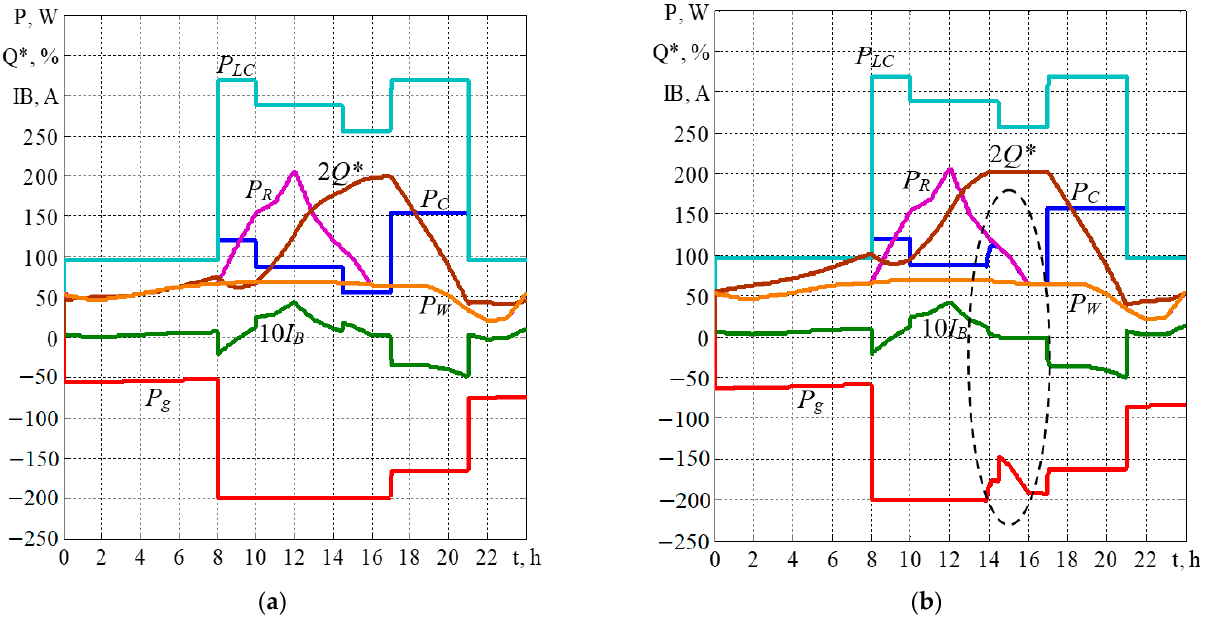
Figure 3. Oscillograms for December Day at the average monthly generation of RES and ρ = 1.6: ( a ) Q* 2 = 35%; ( b ) Q* 2 = 52% ( P LC , load power; P C , load added power; P R , the actual power of RES; P g , power consumed from the grid; P W , WG power; I B , battery current; Q* , battery state of